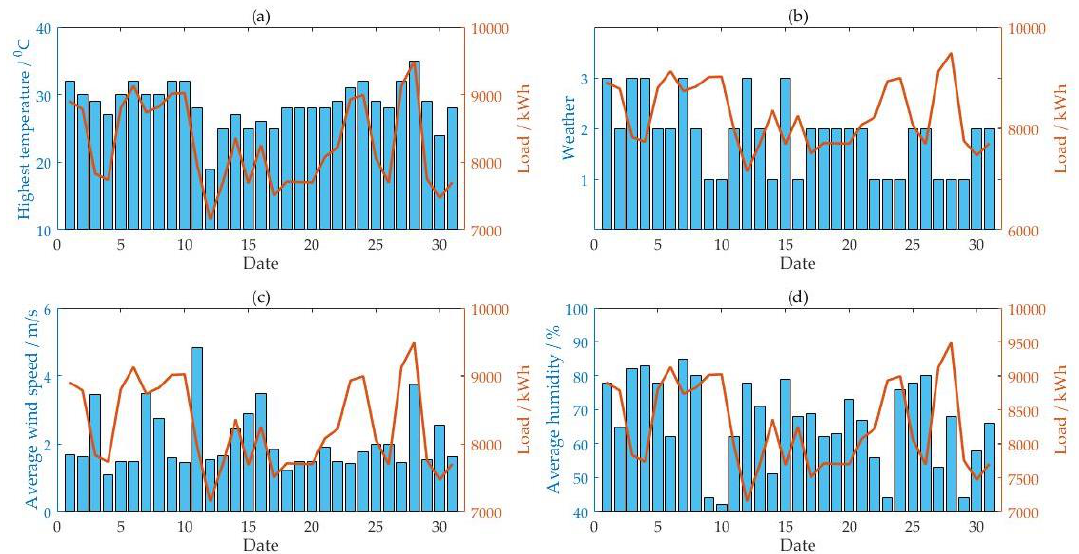
Figure 2. The relationship between meteorological conditions and power load. ( a ) the highest temperature and load; ( b ) the weather and load; ( c ) the average wind speed and load; ( d ) the average humidity and load.